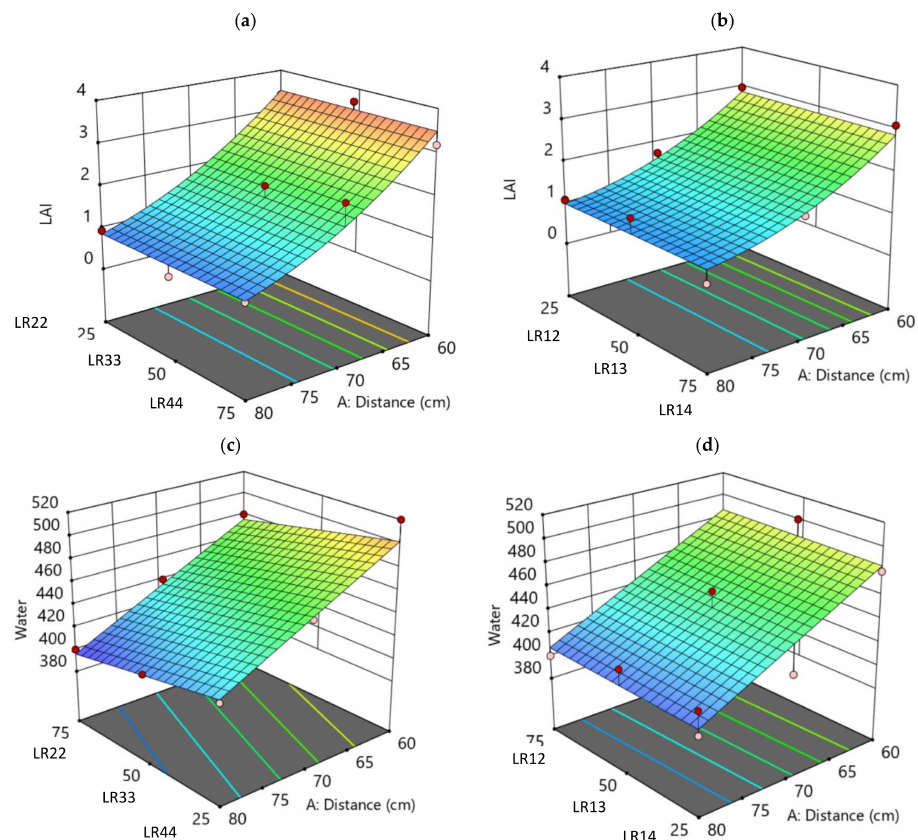
Figure 6. 3D surface contour plots of different responses: LAI, without ( a ) and with ( b ) white LEDs; water, without ( c ) and with ( d ) white LEDs. Reference to Table 7 for light combination code.